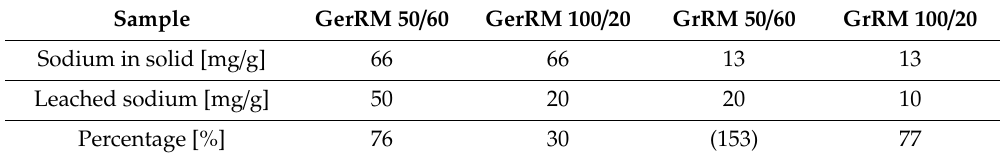
Table 9. Content of sodium at the beginning and after leaching in the types of red